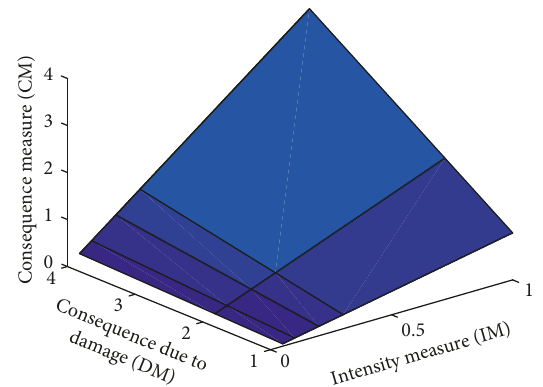
Figure 7: Consequence measure for the considered scenario.